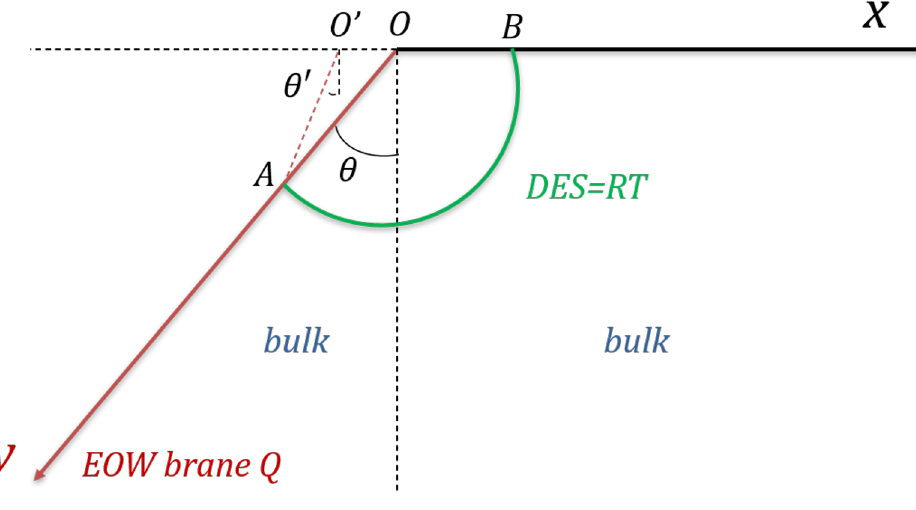
Figure 2 . DES in original BCFT treated as the RT surface in BCFT 0